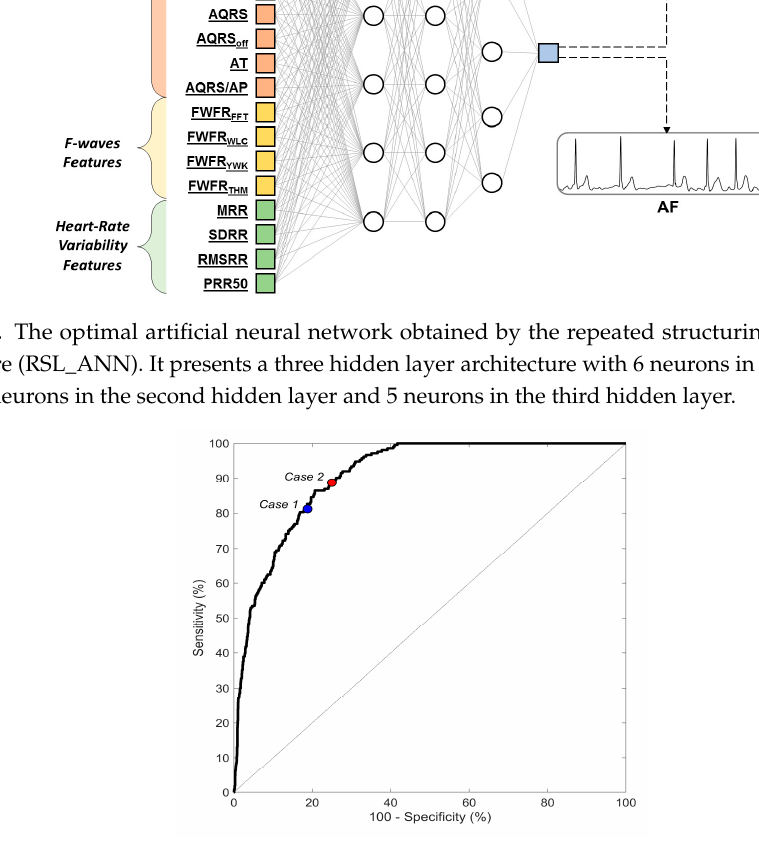
Figure 3. Receiving operating characteristic (ROC) for the testing dataset. The area under the curve (AUC) value is 90.8%. Operating points for Case 1 (blue dot), in which sensitivity (Se) and specificity (Sp) are both equal to 81.2%, and Case 2 (red dot), in which Sp is 75% and Se is 88.7%, are also reported.